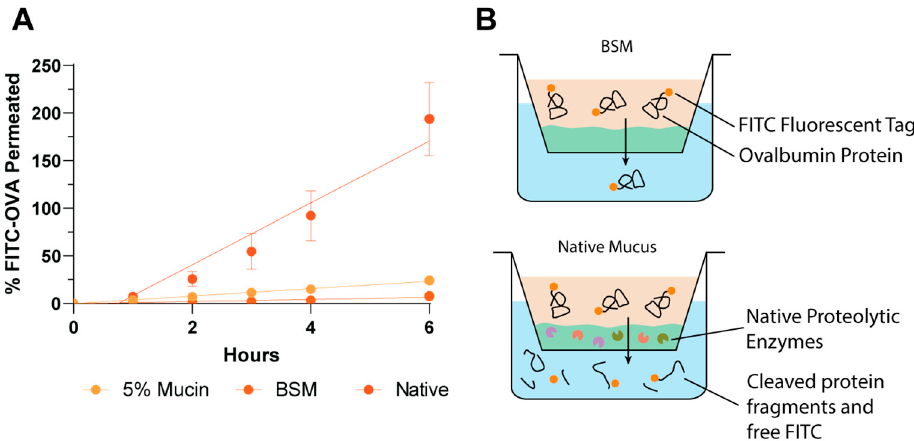
Figure 2. Permeation quantification of free FITC-OVA is incompatible with native mucus. ( A ) FITC- OVA permeation over 6 h detected by FITC fluorescent signal, ( B ) Graphic representation of enzymatic cleavage and free FITC-diffusion in native mucus.